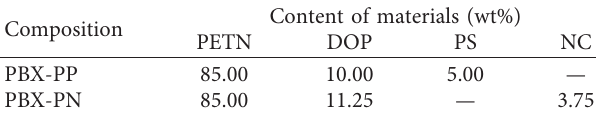
Table 1: The composition of two PBX samples based on PETN.